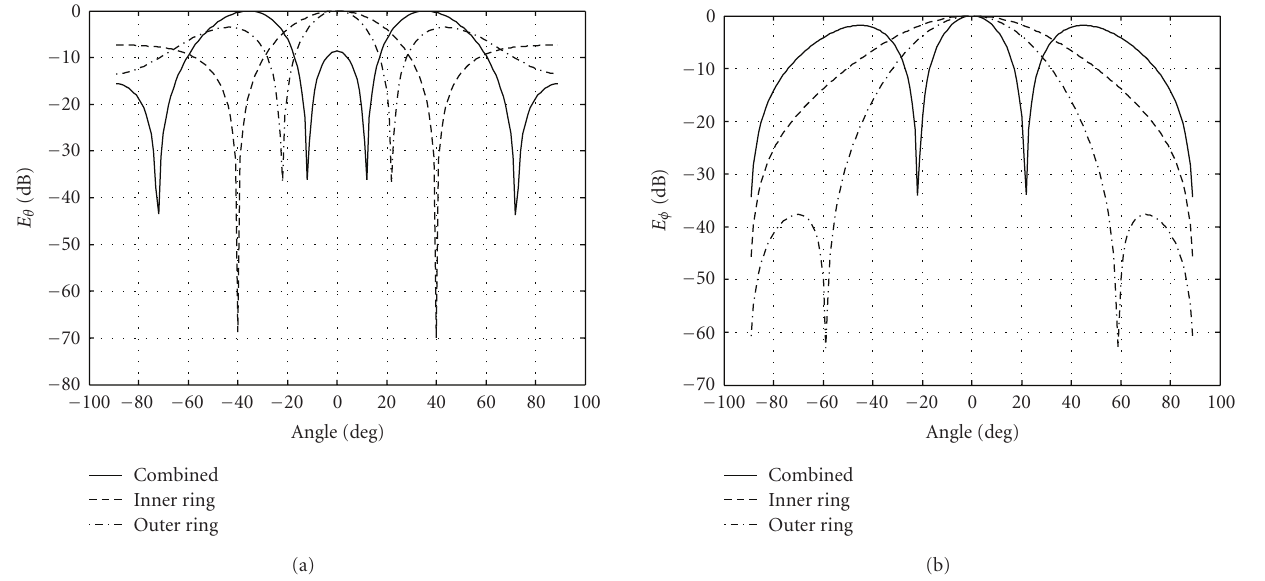
Figure 6: (a) Variation of radiation pattern E θ with angle for S = 0.095 cm. (b) Variation of radiation pattern E φ with angle for S = 0.095 cm.